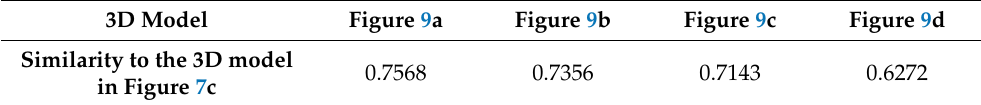
Table 4. Similarity between the reconstructed and groundtruth